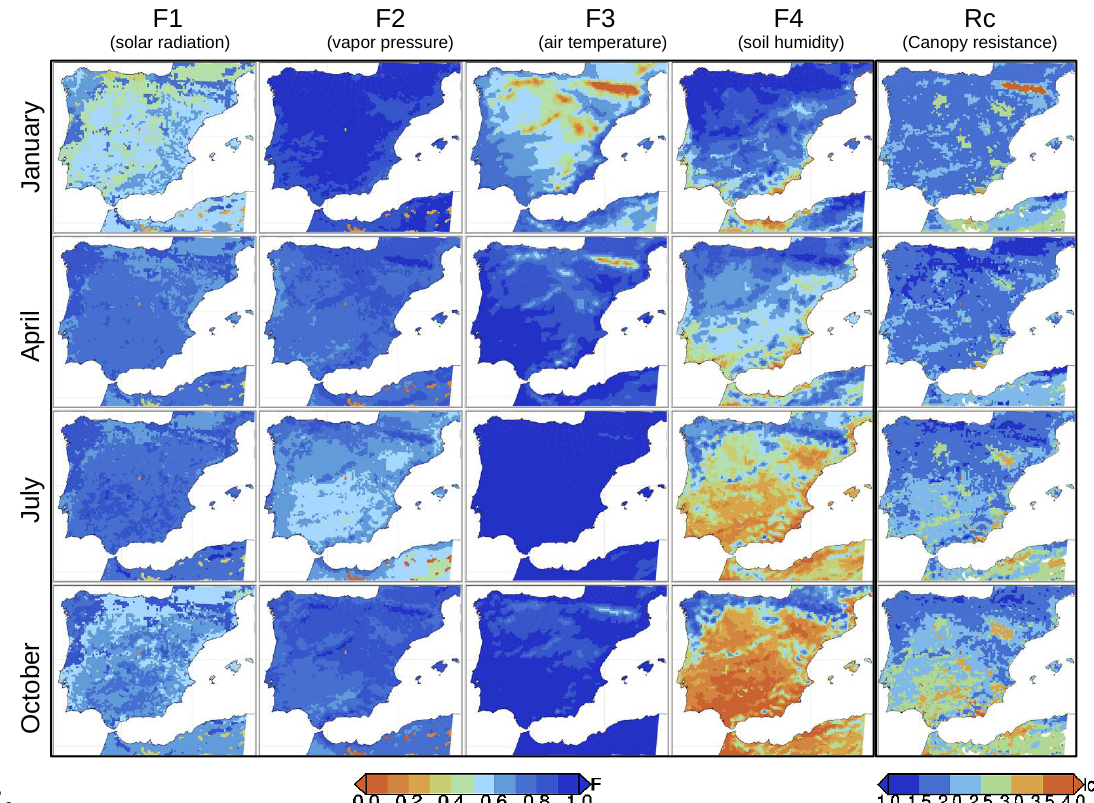
Figure 5. Experiment FVC30. Deficit factors F1, F2, F3, F4 and R c . Monthly means of January, April, July and October.